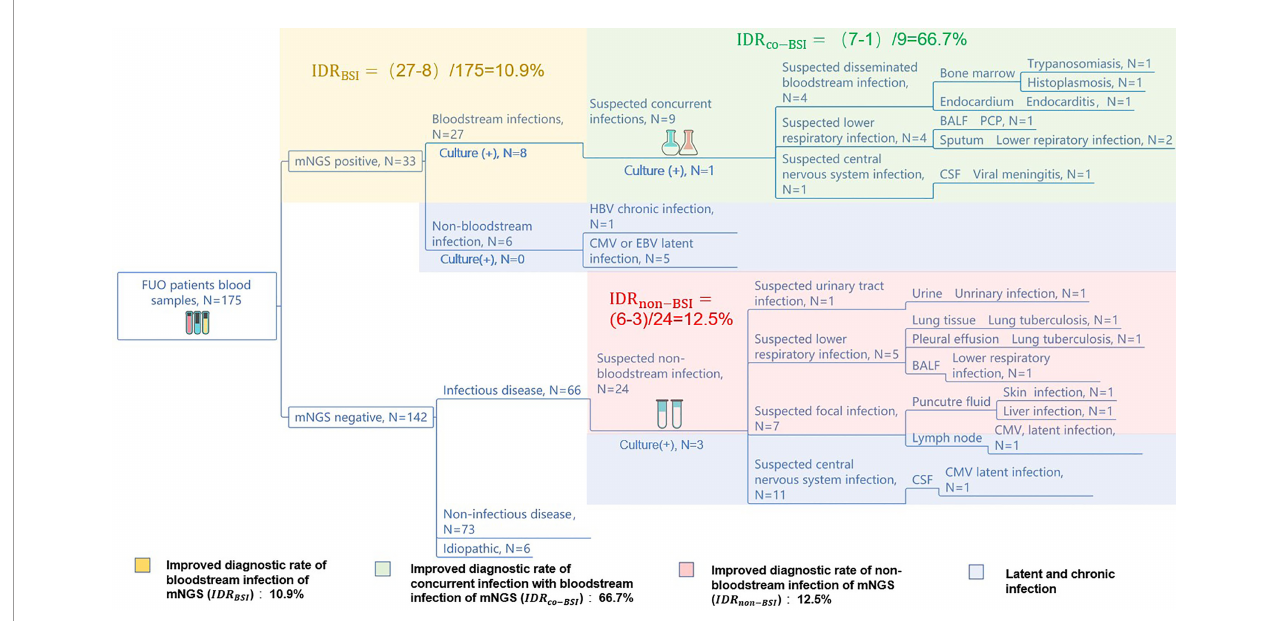
FIGURE 3 | mNGS improves the diagnosis rate of infectious diseases. The diagnostic work fl ows of the 175 FUO patients ’ pathogen identi fi cation. The yellow, green, red, and purple part show the mNGS ’ improving diagnostic rate of bloodstream infections, concurrent infection with bloodstream infection, non-bloodstream infection, and latent or chronic infection, respectively. The numbers of improved rate of mNGS were calculated by: IDR = true mNGS positive cases − culture positive cases suspected infectious cases ,.